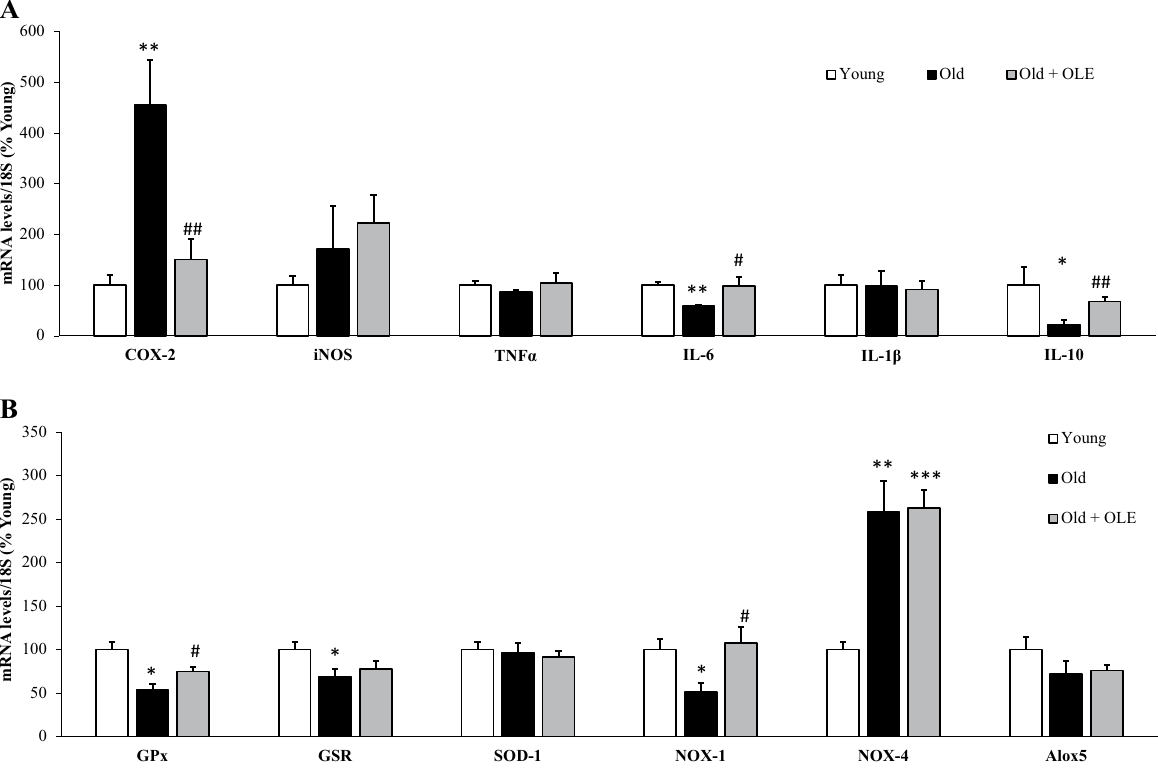
Figure 7. Effects of aging and a 21-day treatment with the OLE on mRNA concentrations of ciclooxigenase-2, inducible Nitric Oxide Synthase, Tumor Necrosis Factor α, Interleukin 6, Interleukin 1β and Interleukin 10 ( A ) and Glutathione Peroxidase, Glutathione Reductase, Super Oxide Dismutase 1, NADPH oxidase 1 and 4, and Lipoxygenase ( B ) in rat aortas. Values are represented as mean ± SEM. * p < 0.05 vs. Young; ** p < 0.01 vs.